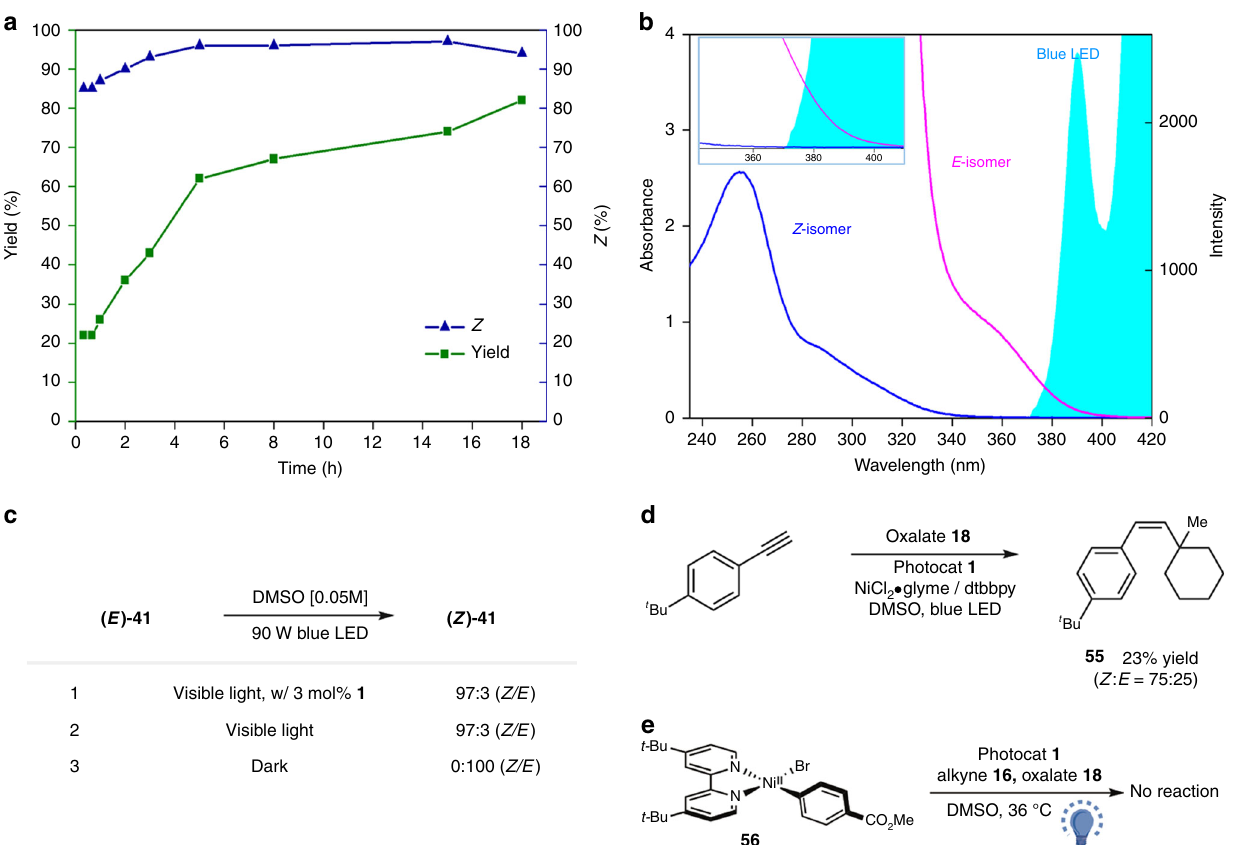
Fig. 5 Mechanistic studies. a Time course studies; b UV – Vis absorption spectrometry; c Isomerization experiments; d Reaction of alkyne with oxalate; e Stoichiometric reaction of isolated Ni(II) complex. dtbbpy = 4,4 ′ -di- tert -butyl-2,2 ′